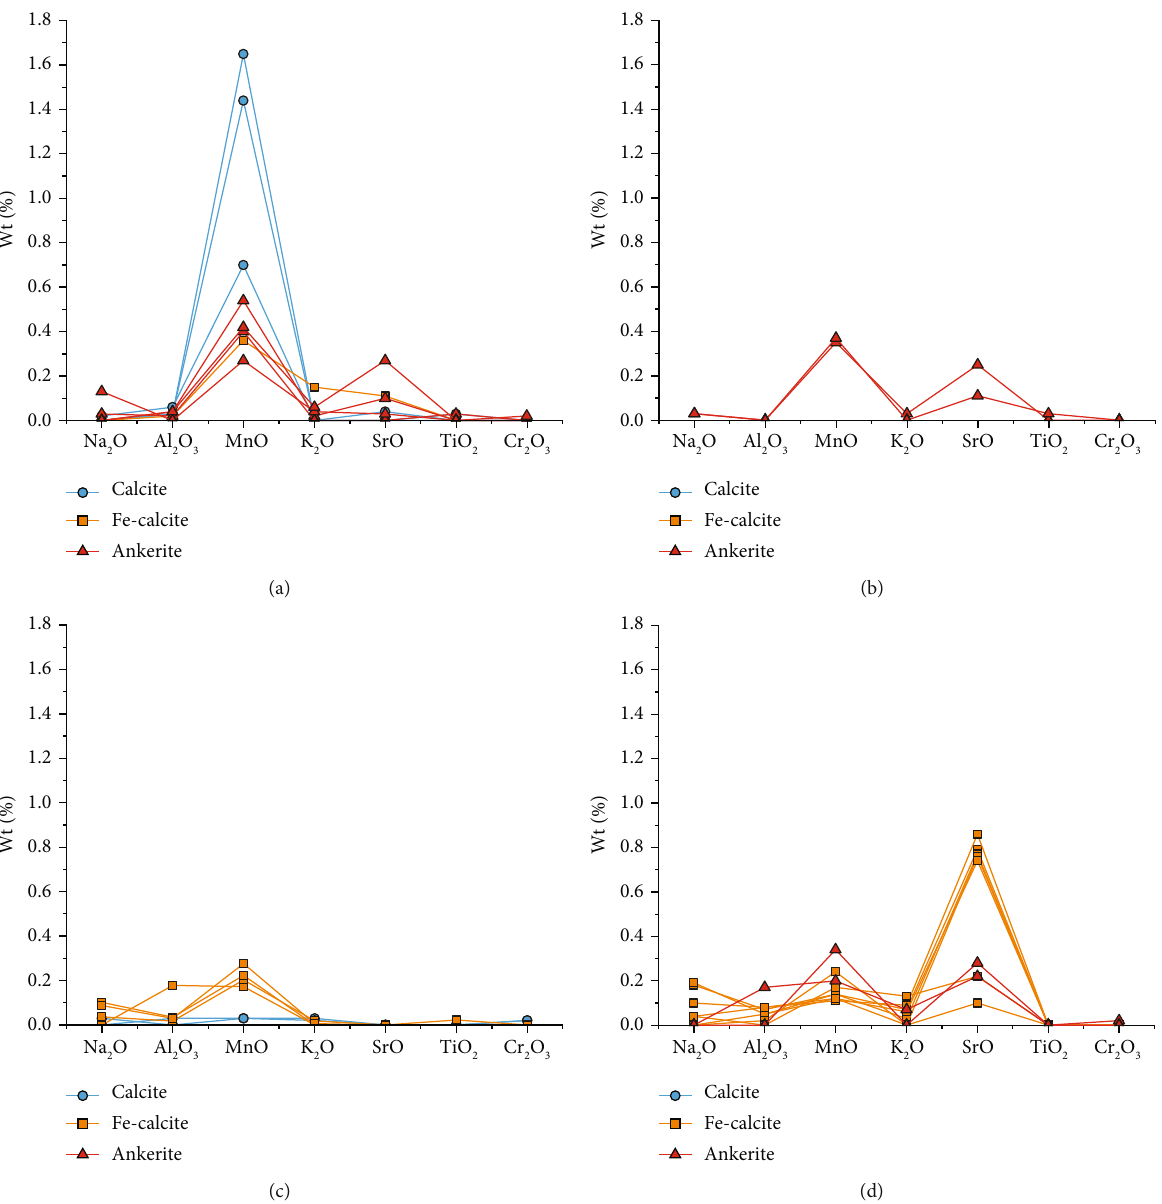
Figure 16: Major elements of carbonate cement from EPMA analysis. (a) F1 well; (b) F31 well; (c) F25 well; and (d) F104